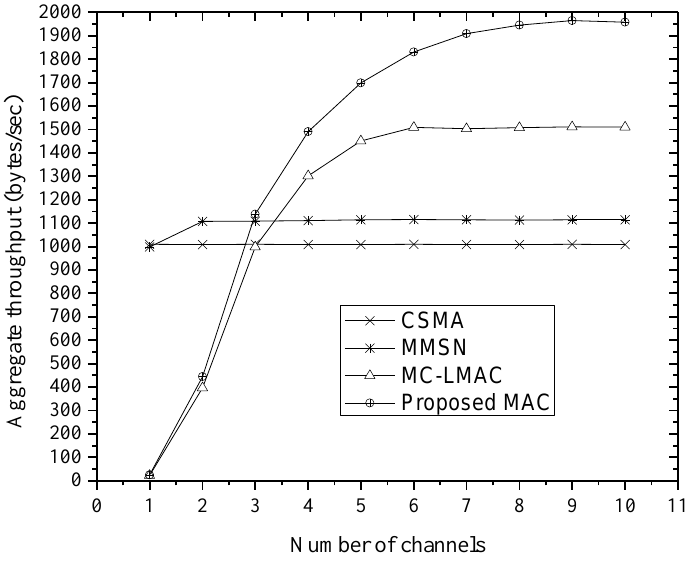
Figure 3. Aggregate throughput with different number of